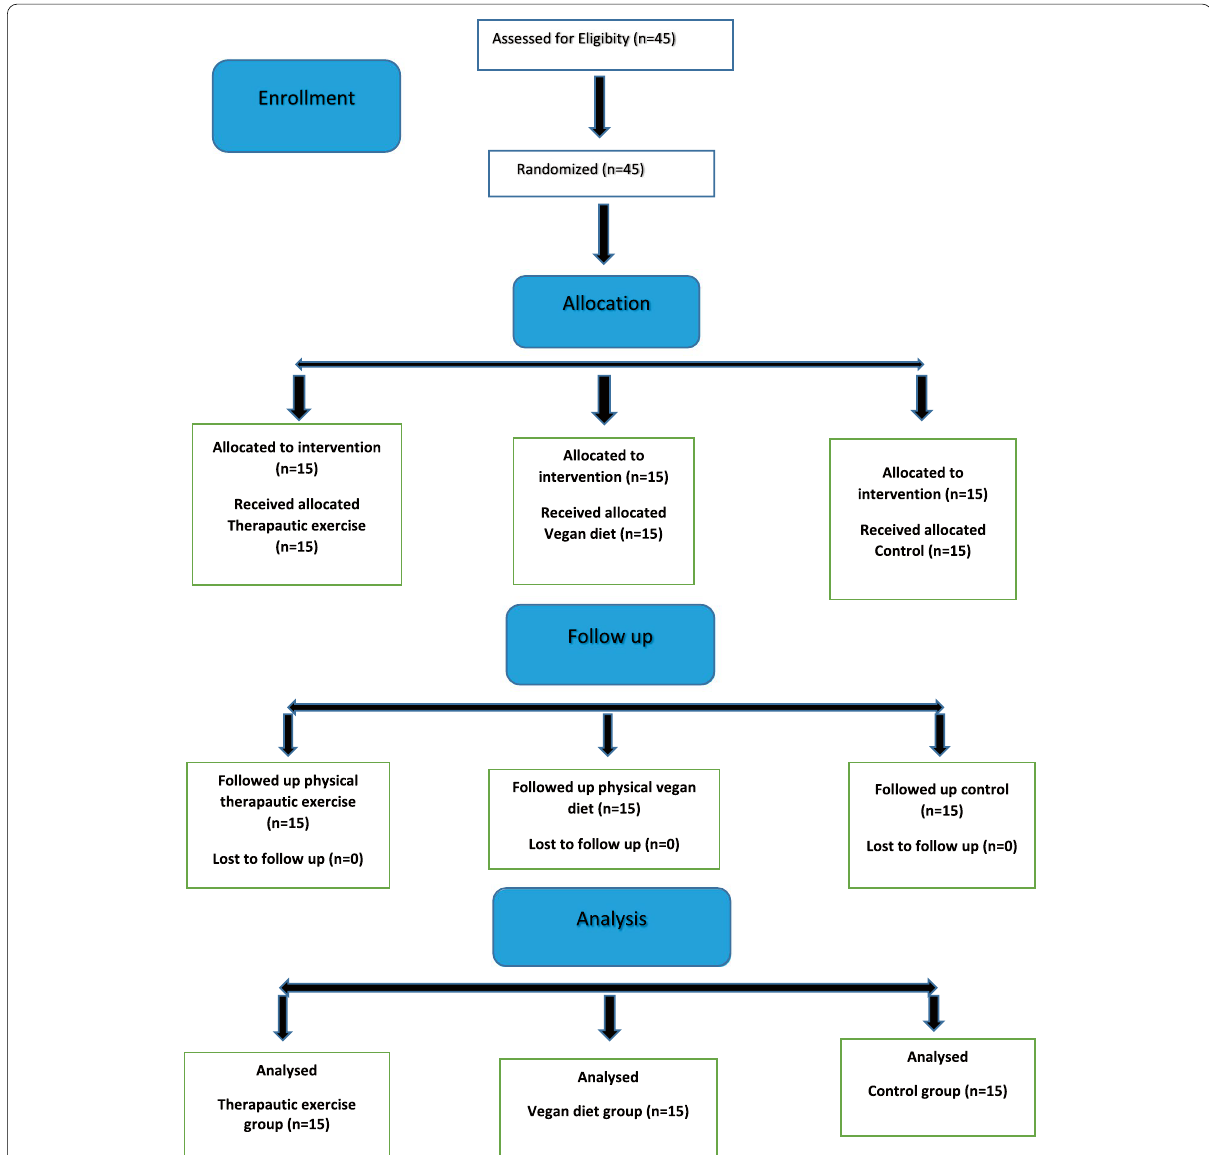
Fig. 1 The diagram describing the patient selection process and study